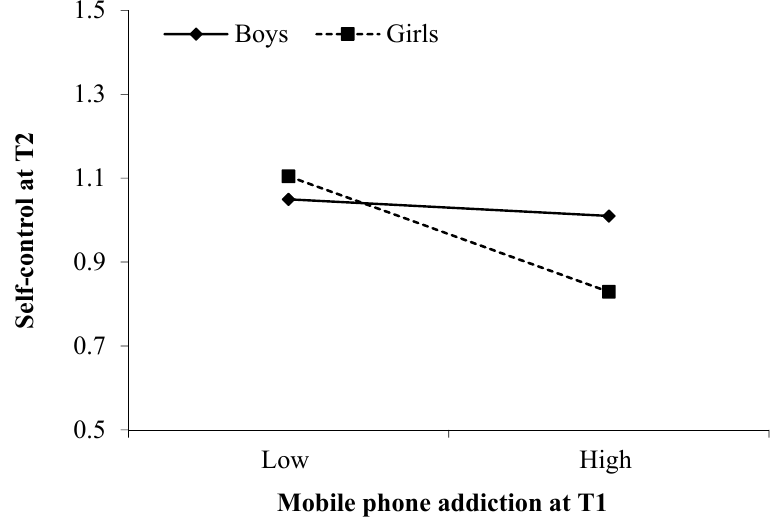
Table 4. The mediation effect of self-control by sex.